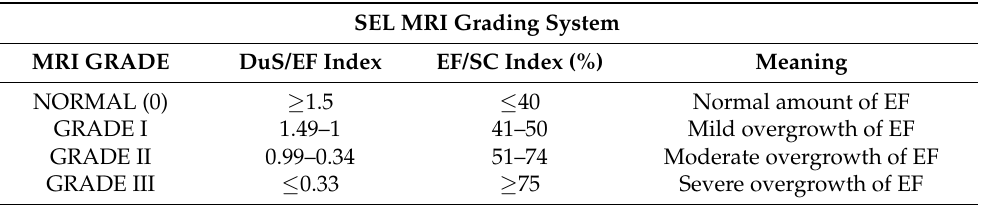
Table 3. MRI Grading System of Lumbar Spinal Epidural Lipomatosis proposed by Borr è et